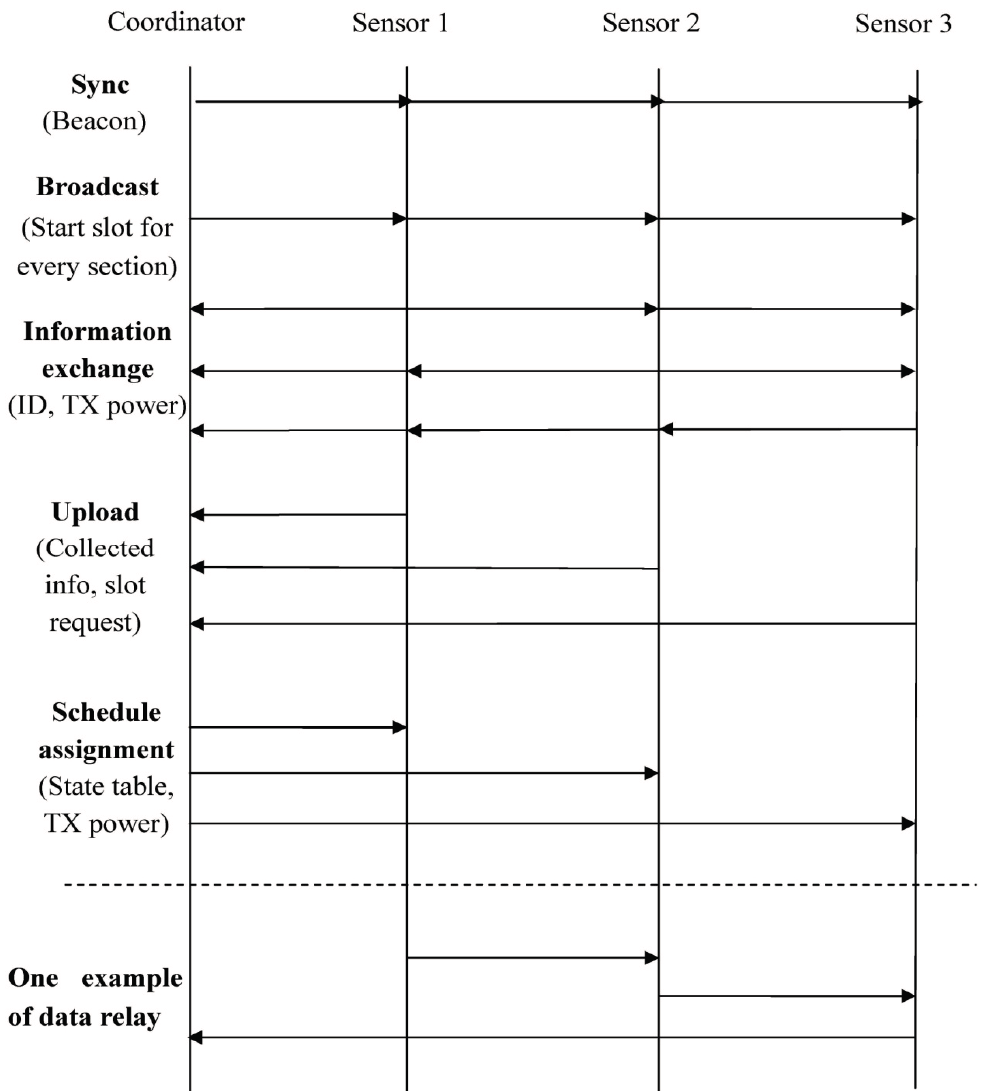
Figure 4. An example of the data transmission schedules in a wireless network with three